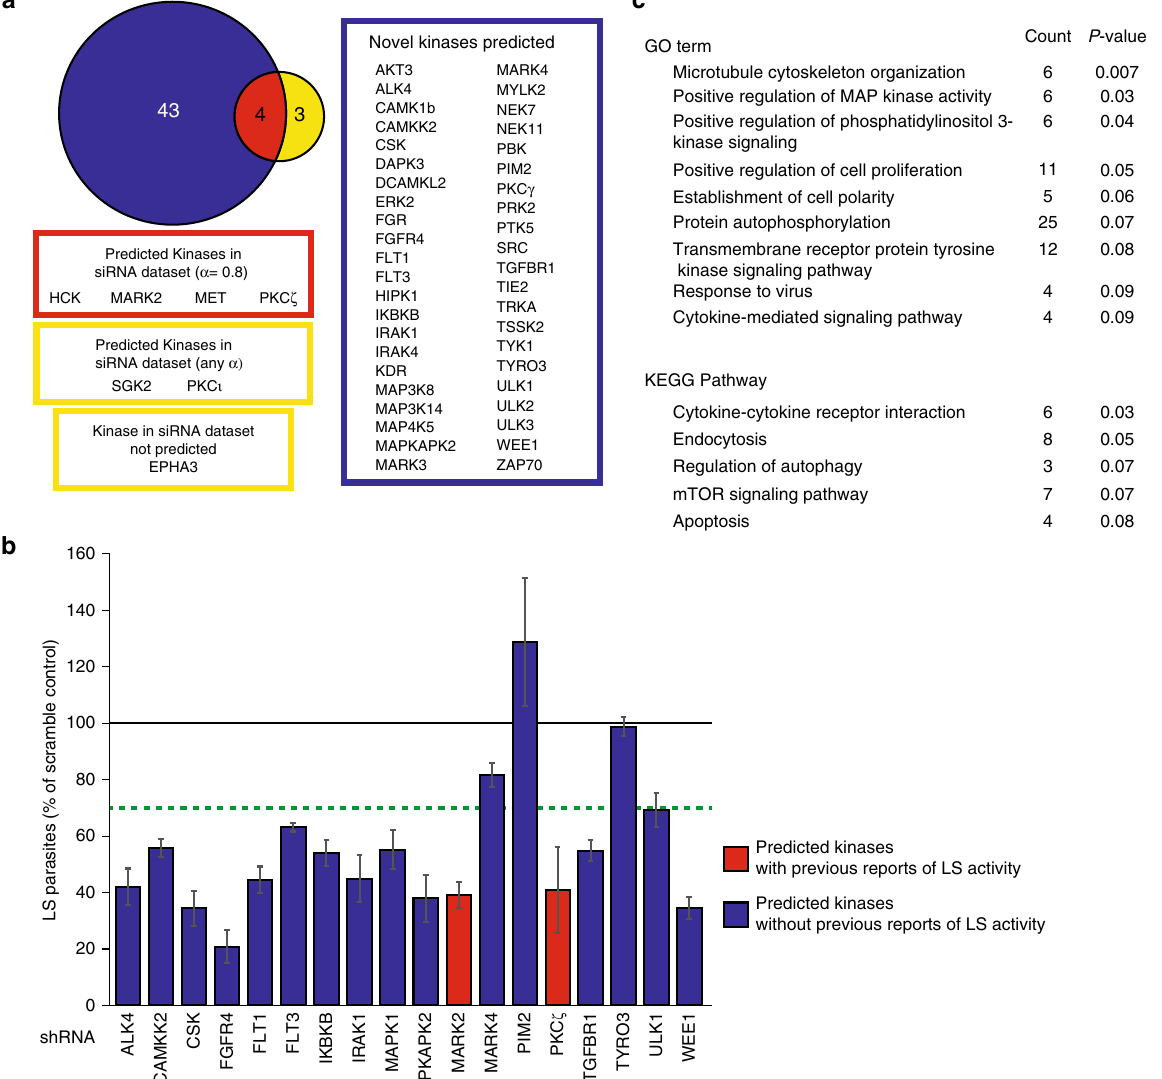
kinases with previous reports of LS activity Predicted kinases without previous reports of LS